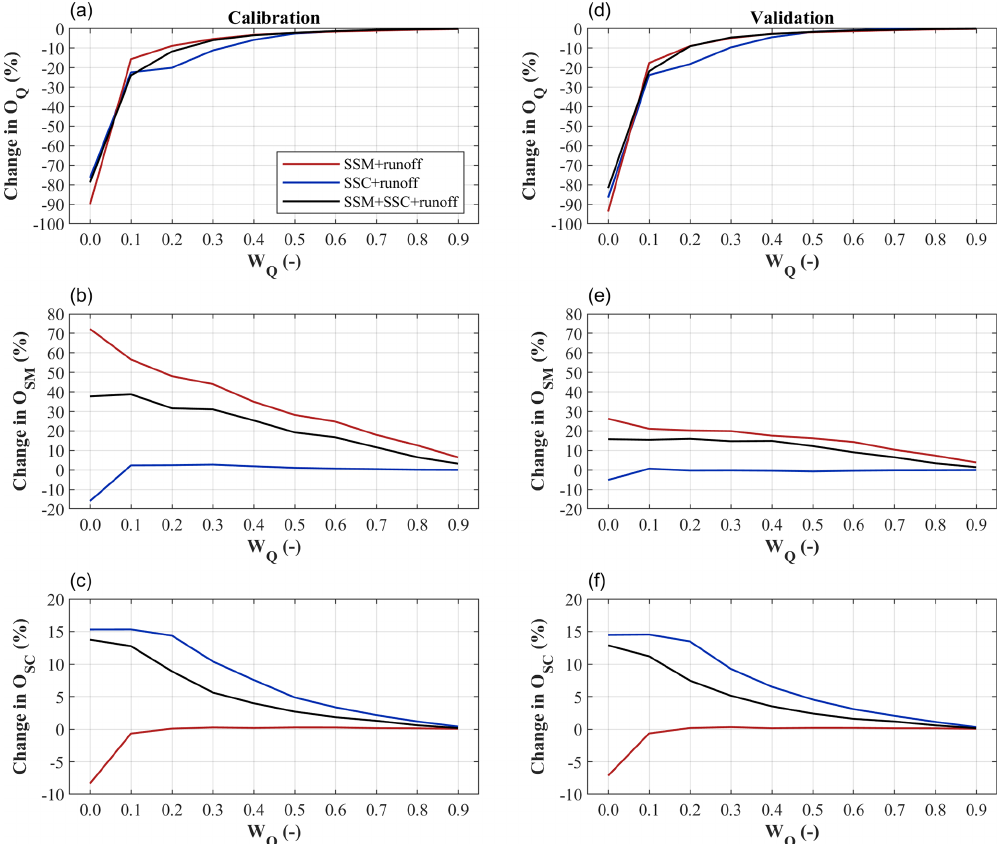
Figure 9. Relative difference in model efficiency ( O Q – runoff model efficiency; O SM – soil moisture model efficiency; O SC – snow model efficiency) of three multiple objective calibration variants (lines), using different runoff weights w Q (Table 3) compared to traditional calibration to runoff only ( w Q = 1). Red, blue, and gray lines represent calibration variants using soil moisture and runoff, snow cover and runoff, and soil moisture, snow cover, and runoff, respectively. Lines represent the median of the 213 Austrian catchments. Panels (a, d) , (b, e) , and (c, f) refer to runoff, soil moisture, and snow cover efficiencies in the calibration (a–c) and validation (d–f) periods, respectively.